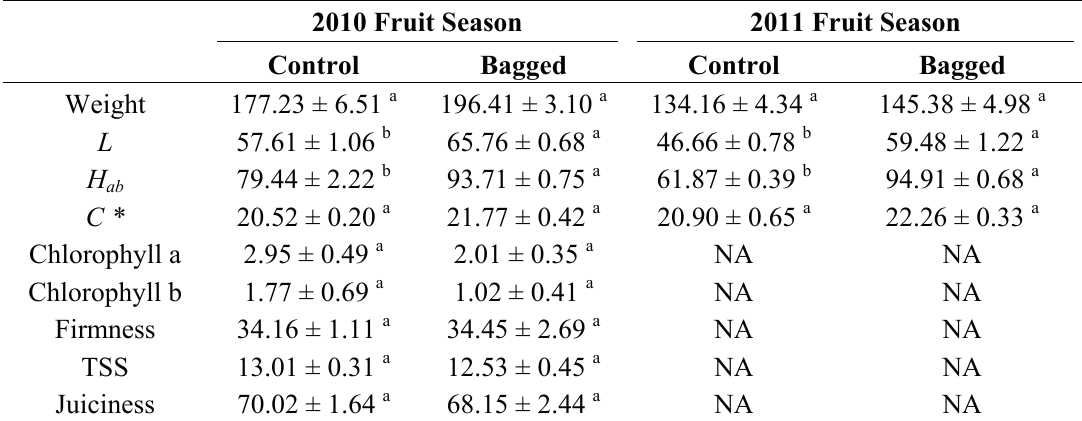
Note: Each value represents the mean ± standard error of three replicates. Values indicated by different letters are significantly different to controls (LSD, 0.05). NA means data not